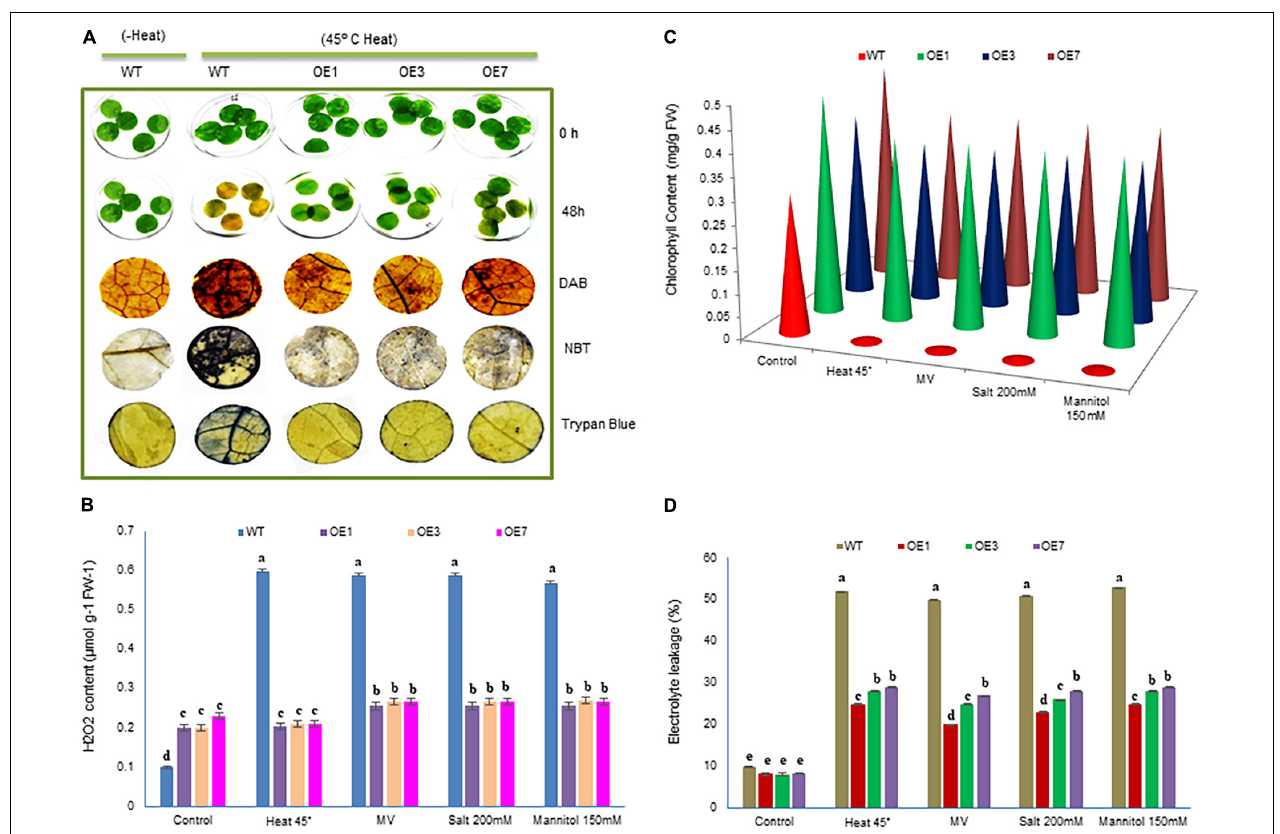
FIGURE 5 | Analysis of cellular damage in response to heat, salinity, and drought stresses. (A) Leaf strips of WT and three transgenic eggplants lines (OE) under 45 ◦ C heat stress for 48 h. Untreated (without heat) WT leaves were used as a control. Relative H 2 O 2 and O 2 − accumulation and dead cells in the leaf strips of transgenic and WT lines were detected by histochemical staining. (B–D) H 2 O 2 , chlorophyll content, and electrolytic leakage were measured in response to heat, salinity, MV (methyl viologen), and osmotic stresses. Data are M ± SD ( n = 3). The letters a, b, c, and others indicate significant differences between different lines ( P < 0.05).